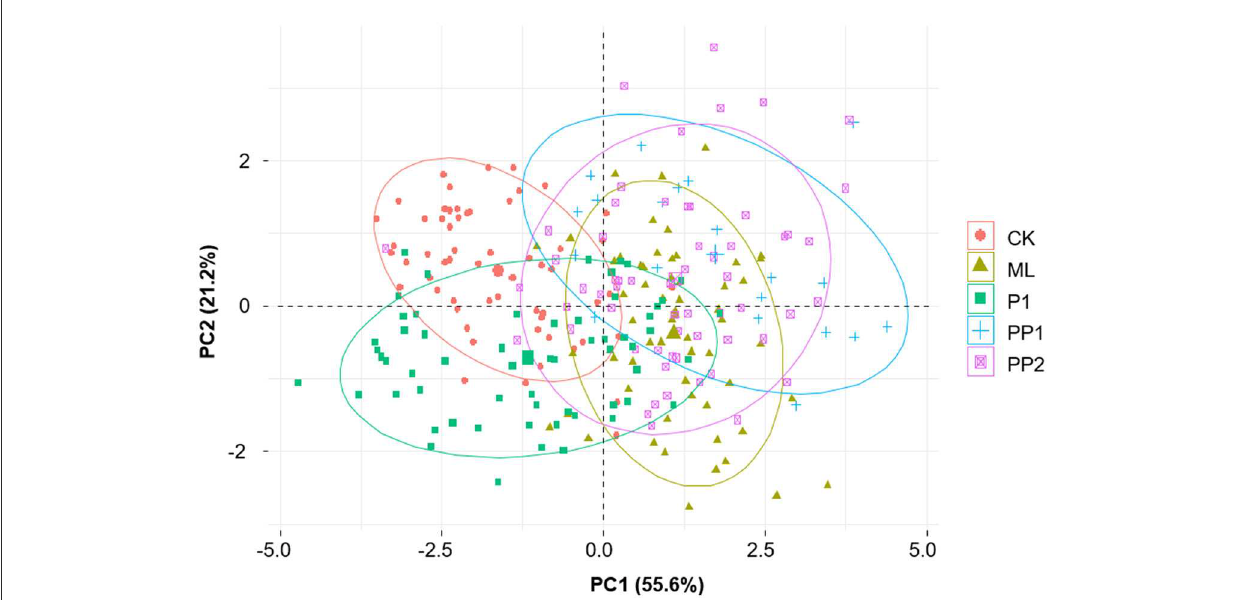
FIGURE5 PCA plot for the appendage sizes in honeybee broods exposed to high temperatures for 16h. Each dot indicates the appendage sizes of an individual bee, and the shapes of colored dots represent experiment groups: CK, control group; ML, mature larva; PP1, the first day of prepupa; PP2, the second day of prepupa; P1, the first day of the pupa. The horizontal and vertical axes represent PC1 and PC2, respectively. The numbers in the parentheses show the proportion of the variance explained by PC1 and PC2. Morphologically similar samples will be plotted close to each other (ellipse of 90% confidence interval). Raw data are available in Supplementary Table